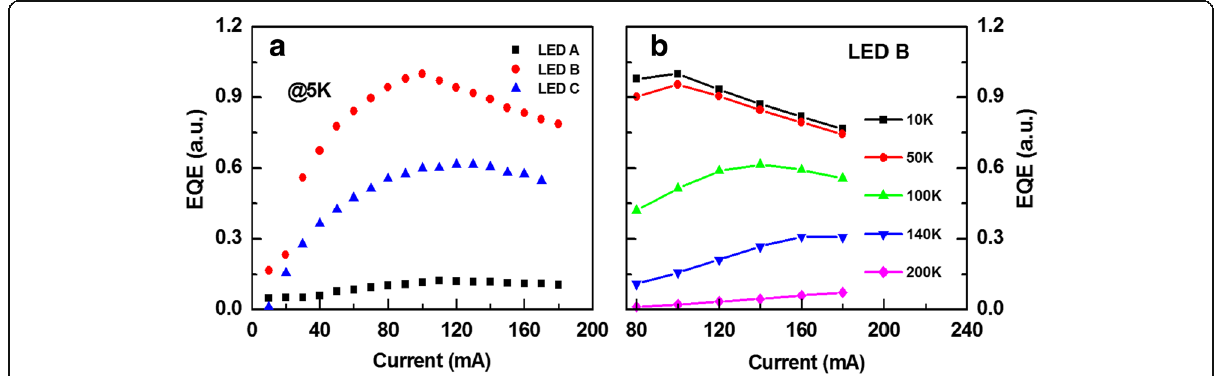
Fig. 3 a The relative EQE at 5 K and ( b ) the current-dependent relative EQE at different temperature for LED